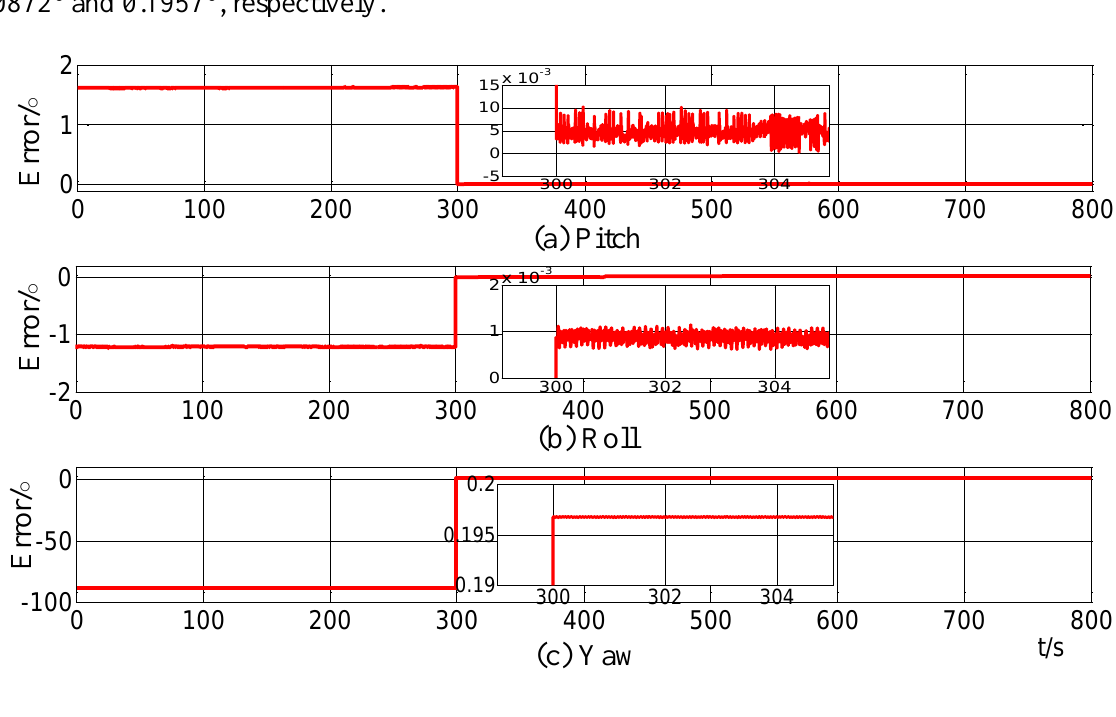
Figure 19. Curves of alignment errors for the vehicle